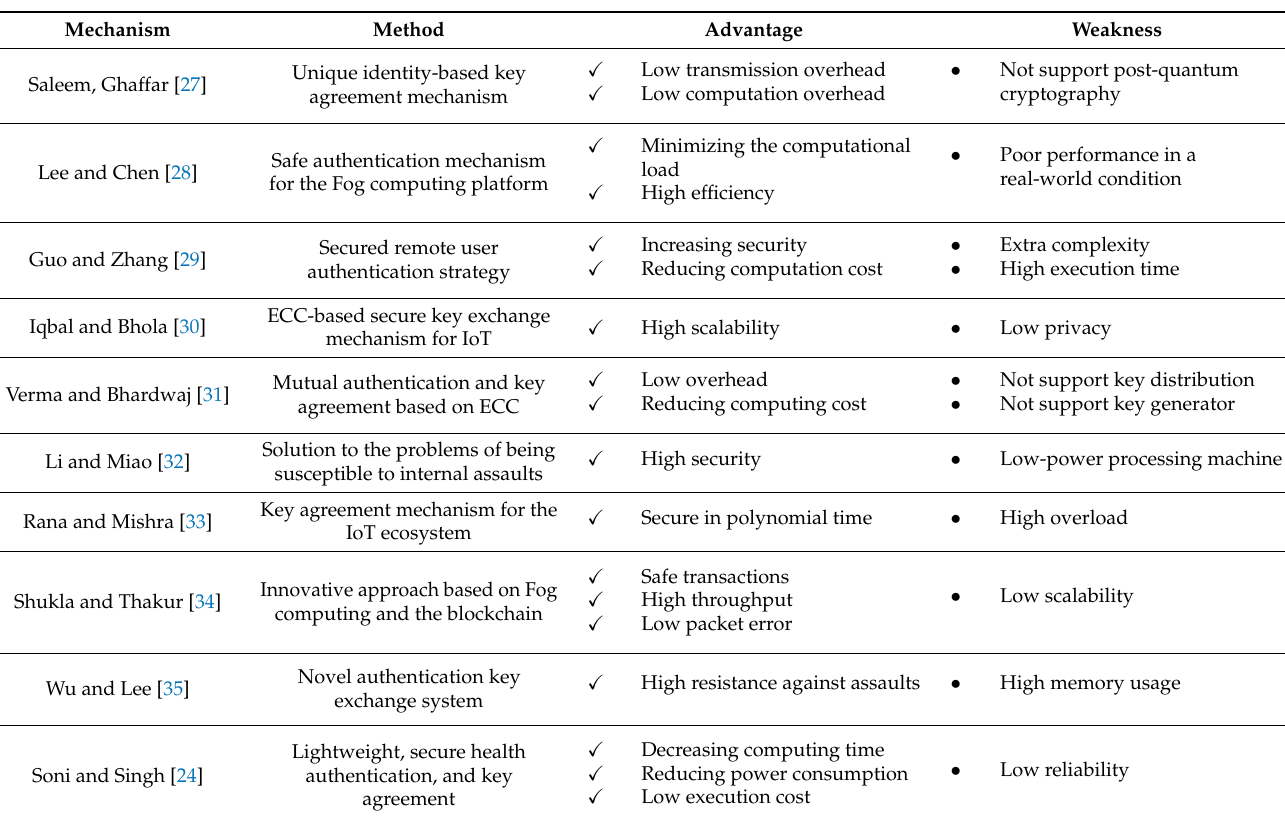
Table 1. Summary of the techniques